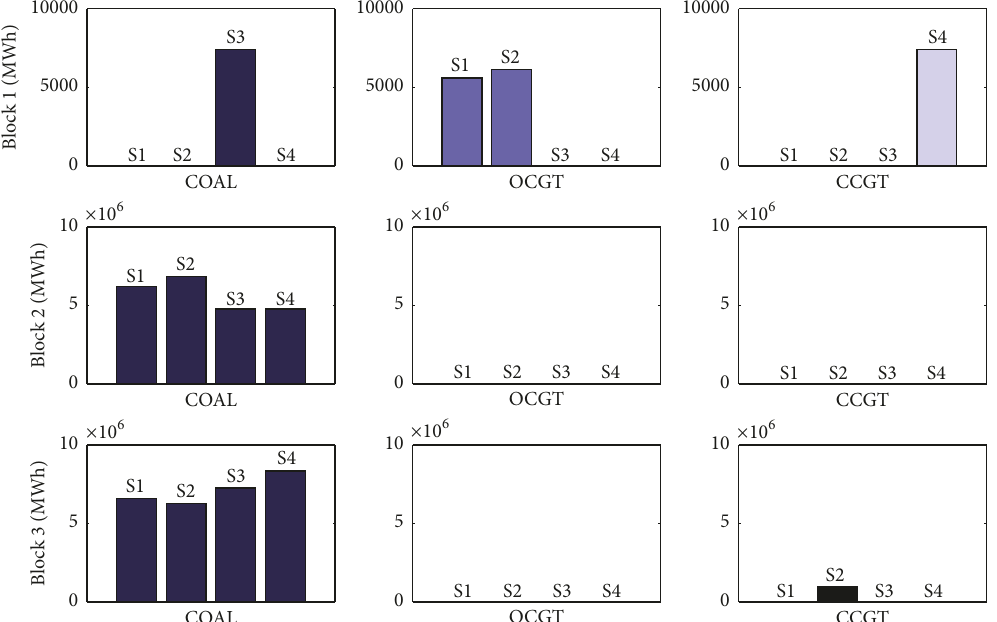
Figure 9: MPC solution use for each